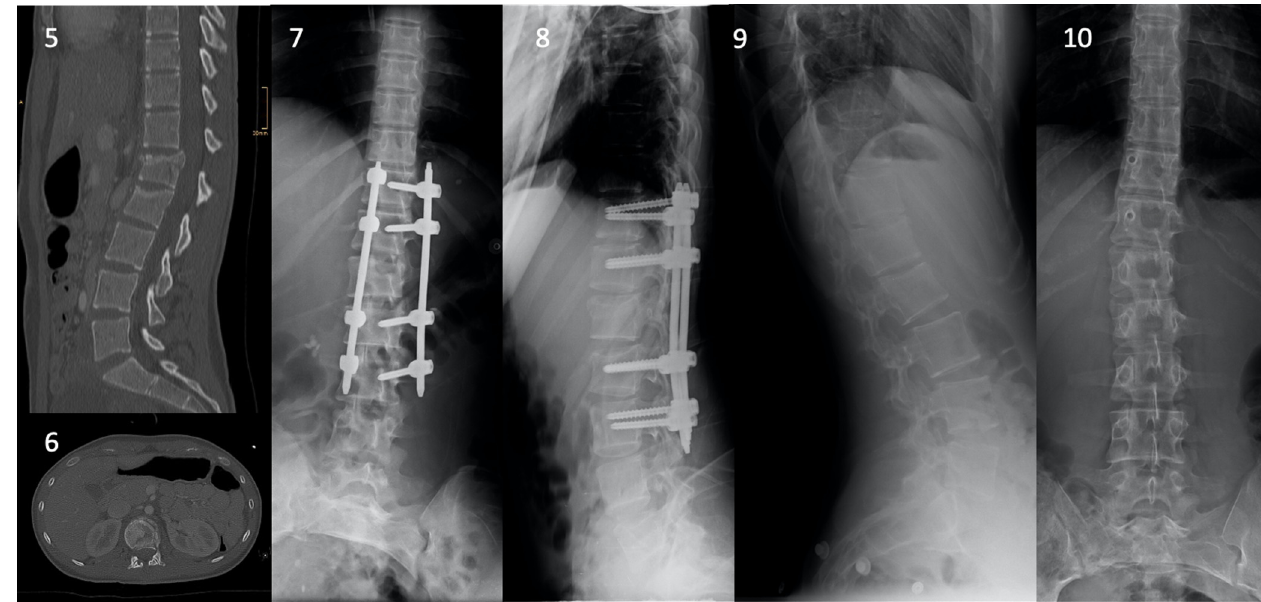
Figure 5. Images 5 and 6 illustrate a sagittal and axial CT scan of a 15-year-old girl with an A3.3 L1 fracture and an A3.1 L2 fracture after a suicide attempt by jumping from a bridge (height > 3 m). Images 7 and 8 show post-operative radiographs of the posterior stabilisation. Images 9 and 10 are the last radiographs obtained after implant removal (7 months post-operative), showing a fully consolidated fracture.